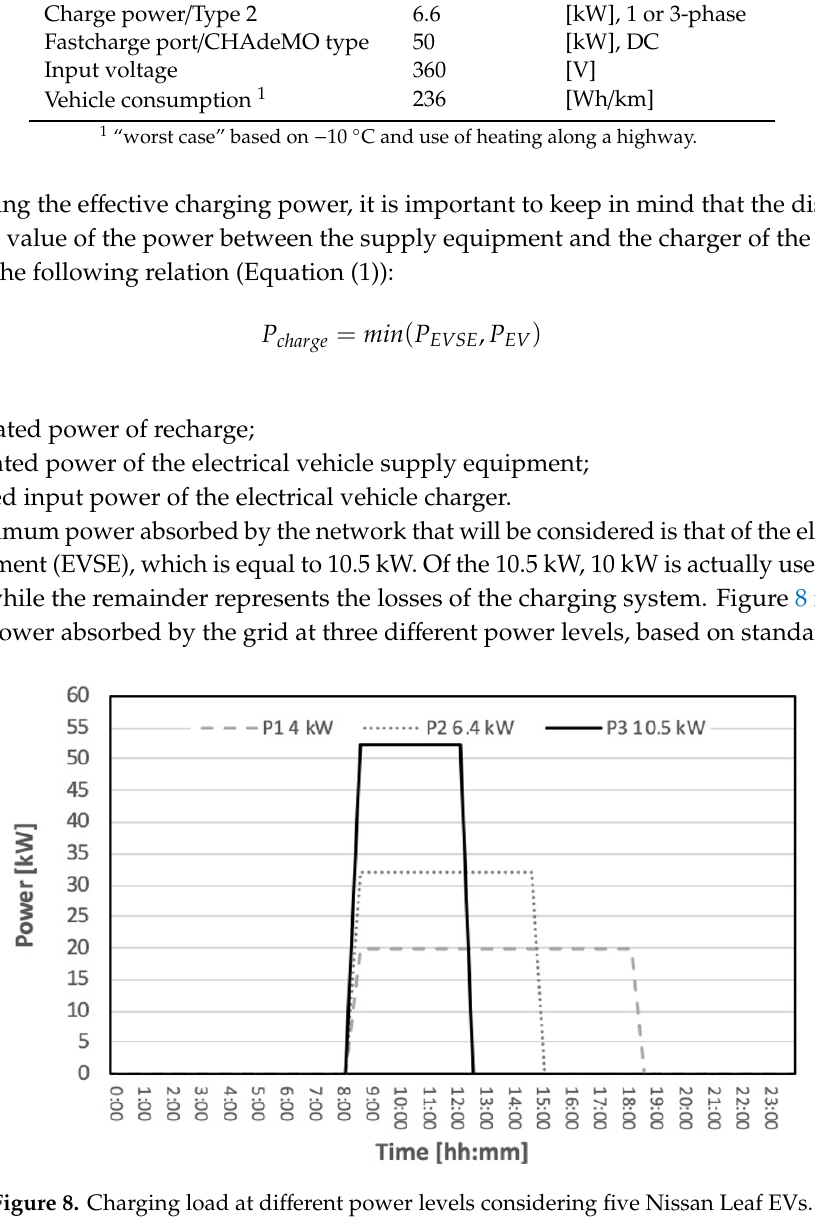
Figure 8. Charging load at different power levels considering five Nissan Leaf EVs .